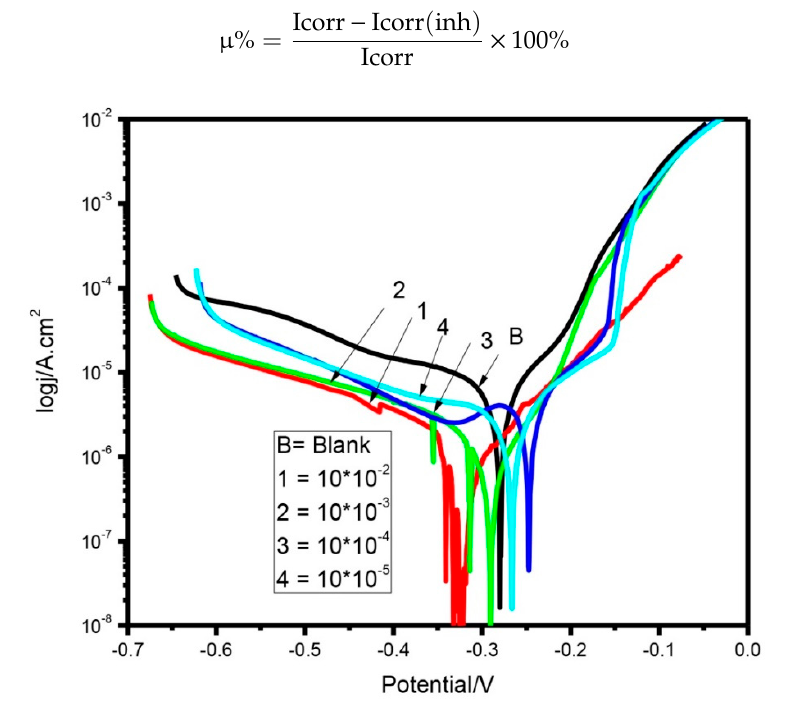
Figure 1. Potentiodynamic polarization curves for the Cu5Zn5Al1Sn alloy after 60 min immersion in 3.5 wt.% NaCl in the absence (Blank) and presence of different concentrations of cysteine (10 -5 to 10 -2 ). Table 1. Polarization parameters for the Cu5Zn5Al1Sn alloy measured in 3.5 wt.% NaCl solution in the absence and presence of different concentrations of cysteine.